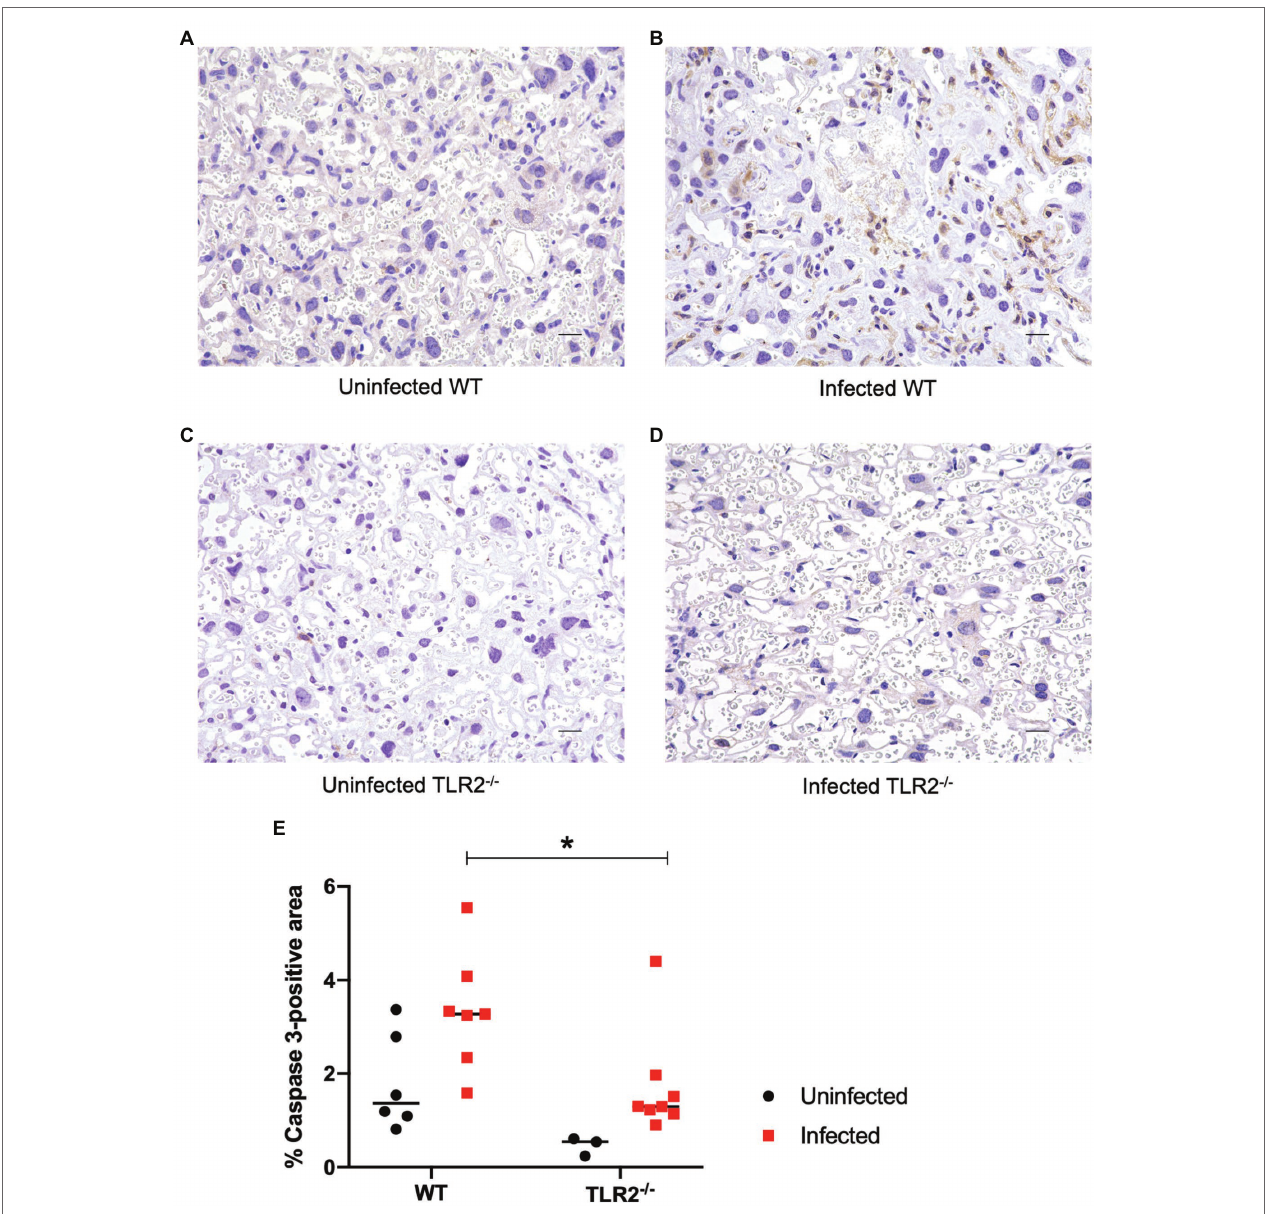
FIGURE 5 | Immunohistochemistry and image analysis for caspase-3 in the placenta on day 18.5 of pregnancy. Trophoblasts and endothelial cells were positive for caspase-3 in the placenta of the infected wild-type mice. Representative photographs are shown. (A) The placenta of an uninfected wild-type mouse. (B) The placenta of an infected wild-type mouse. (C) The placenta of an infected TLR2 − / − mouse. (D) The placenta of an infected TLR2 − / − mouse. Bar = 20 μ m. Trophoblasts and endothelial cells were positive for caspase-3 in an infected wild-type mice. (E) Image analysis of immunihistochemistry for caspase-3. Positive areas were compared between WT and TLR2 − / − mice. Horizontal bars represent the mean value. Data were analyzed with two-way ANOVA followed by the Tukey–Kramer multiple-comparison test. * p <